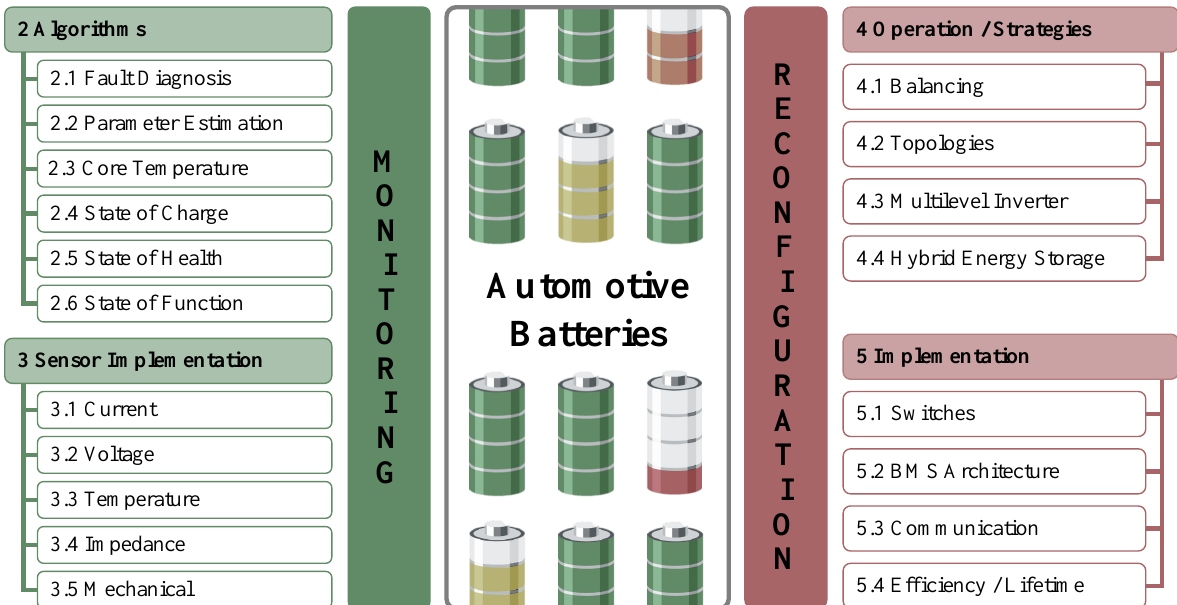
Figure 1. Overview of the aspects of advanced monitoring and reconfiguration to solve the main challenges of automotive batteries. The figure also serves as a graphical table of